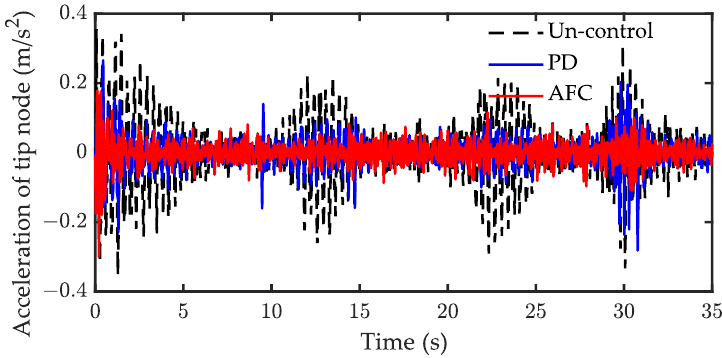
Figure 23. Experiment result of acceleration response for case 2 ( = 5,000 ).